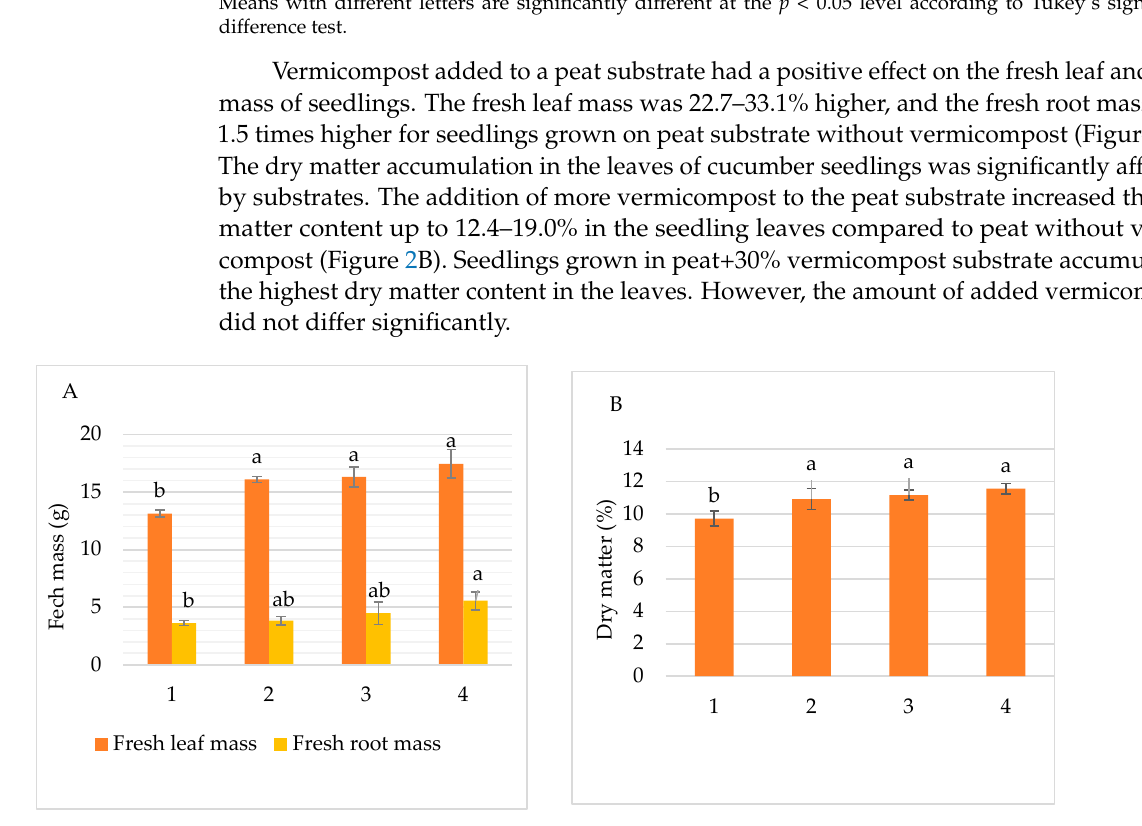
Figure 2. The effect of peat–vermicompost substrates on the fresh leaf and root mass ( A ) of cucumber seedlings and dry matter content ( B ) in the leaves of seedlings: 1—peat; 2—peat + 10% vermicompost; 3—peat+20% vermicompost; 4—peat+30% vermicompost. Means with different letters are significantly different at the p < 0.05 level according to Tukey’s significant difference test. Error bars shows standard deviation.